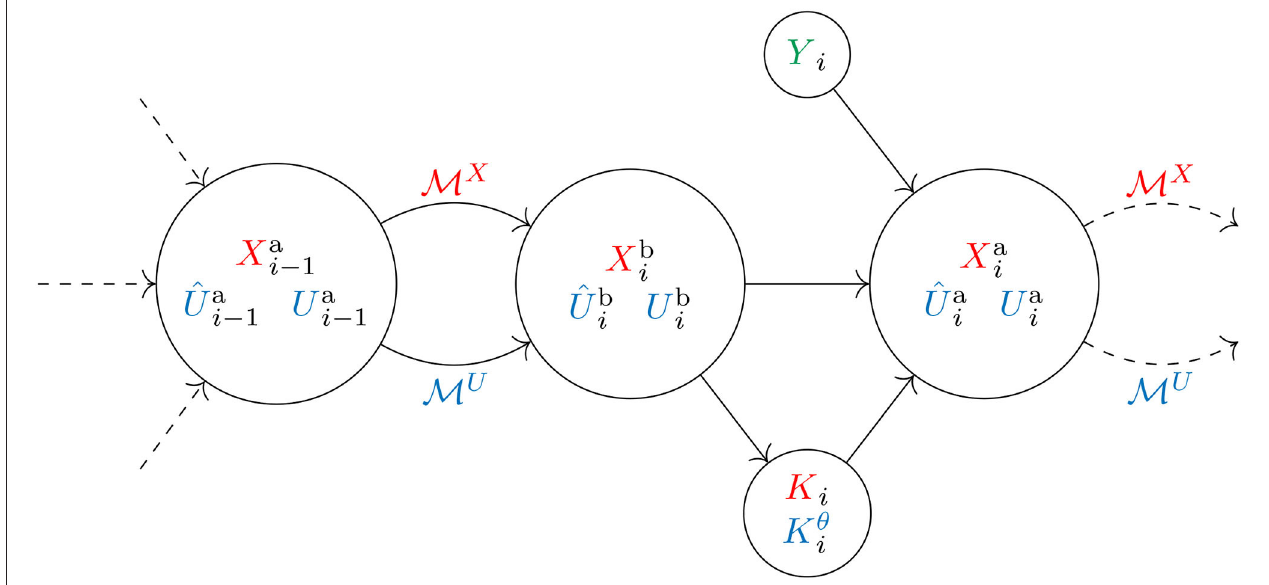
FIGURE 1 | A visual diagram of the NL-MFEnKF algorithm. The random variables are represented by an ensemble of realizations, and the directional acyclic graph provides an explicit (infinite) causal